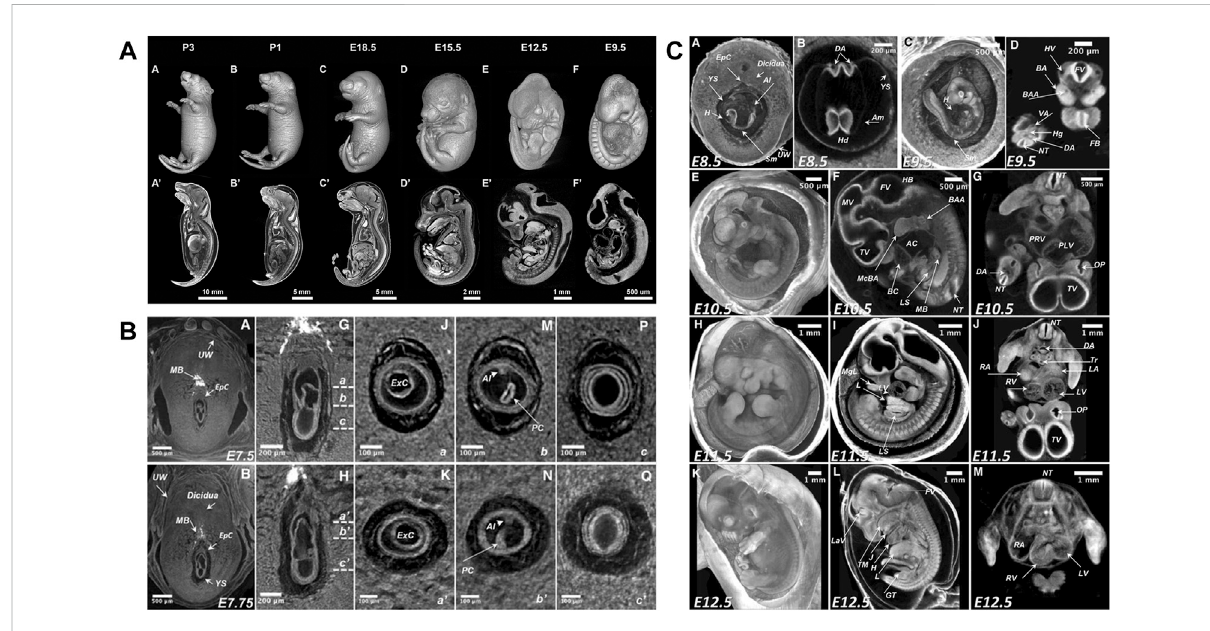
FIGURE 4 MicroCT slices fromvolume datasets and volume renderings of thedeveloping mouse atselected stages. (A) Documentation ofnormalmouse development from postimplantation to early postnatal stages after aldehyde fi xation and iodine staining [Figure 1 from Hsu et al., 2016, Developmental Biology 419 (2)]. (B) Detailed depiction of the gastrulation period around E7.5 (parts of Figure 3 from Ermakova et al., 2018,